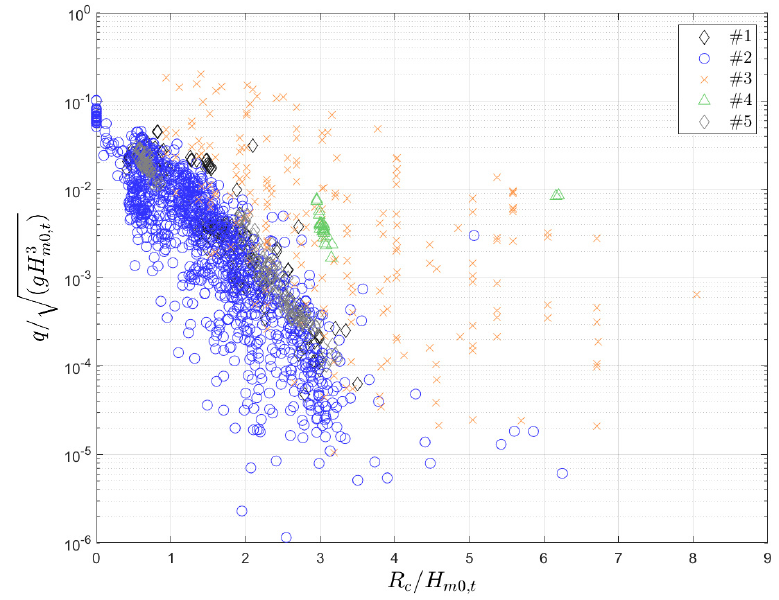
√ ( gH m 03 ) versus with the dimensionless